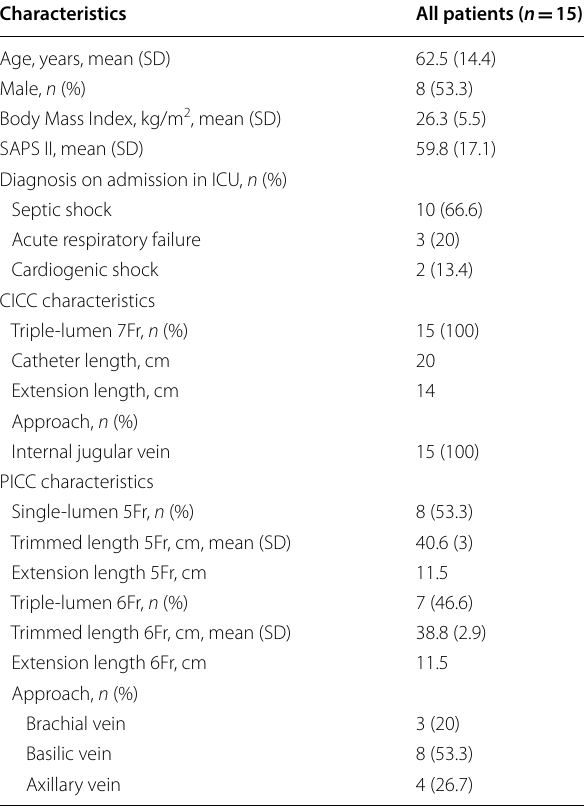
Table 1 Patient population: demographic and clinical characteristics